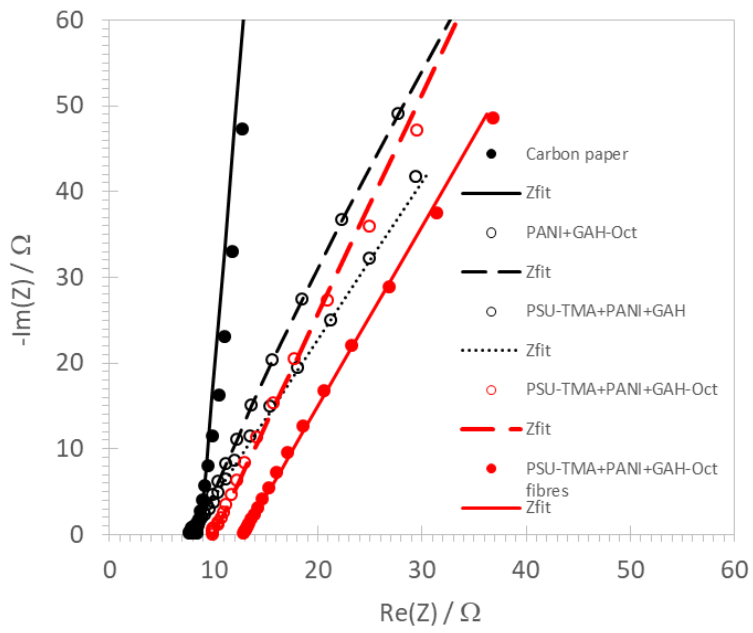
Figure 4. Impedance spectra of ORR electrodes at 1000 rpm in O 2 -saturated 1 M